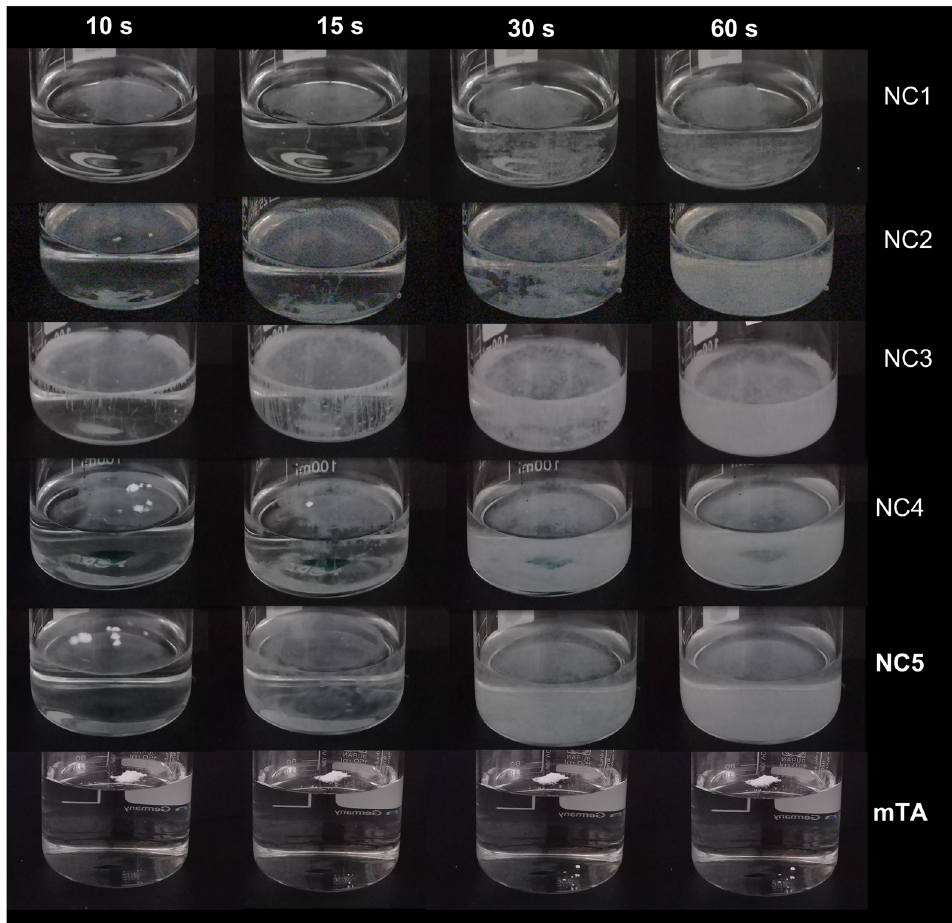
Figure 2. Illustrative images of the aqueous self-dispersion of the powdered TA-NC at 0, 15, 30 and 60 s.